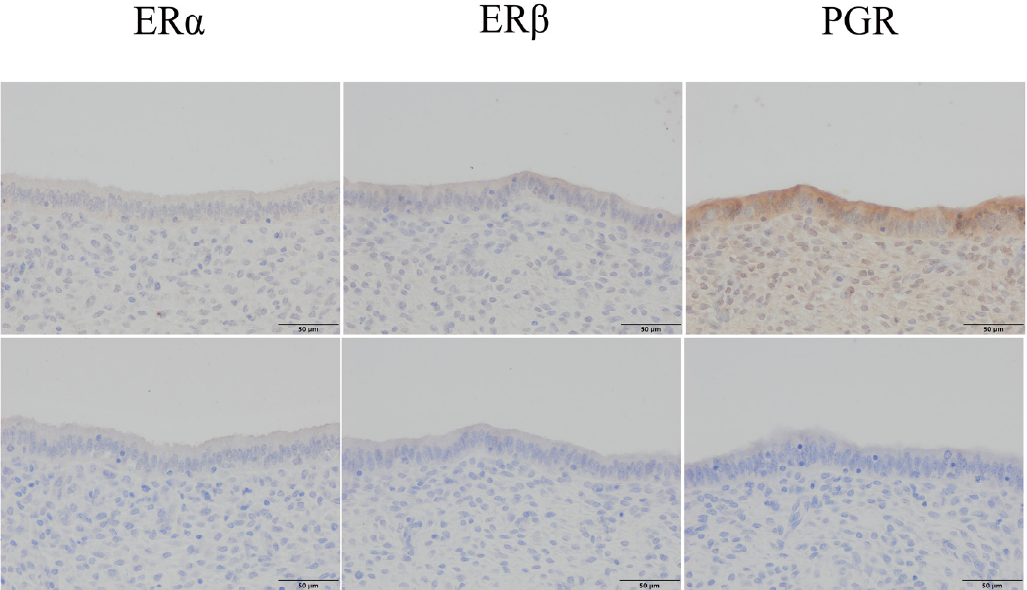
Figure 8. Immunohistochemical staining of ER α , ER β , and PGR in sheep uterine samples. Original magnification, 400×. The upper layer is positive for ER α , ER β , and PGR, while the lower layer is the negative control of the same part.